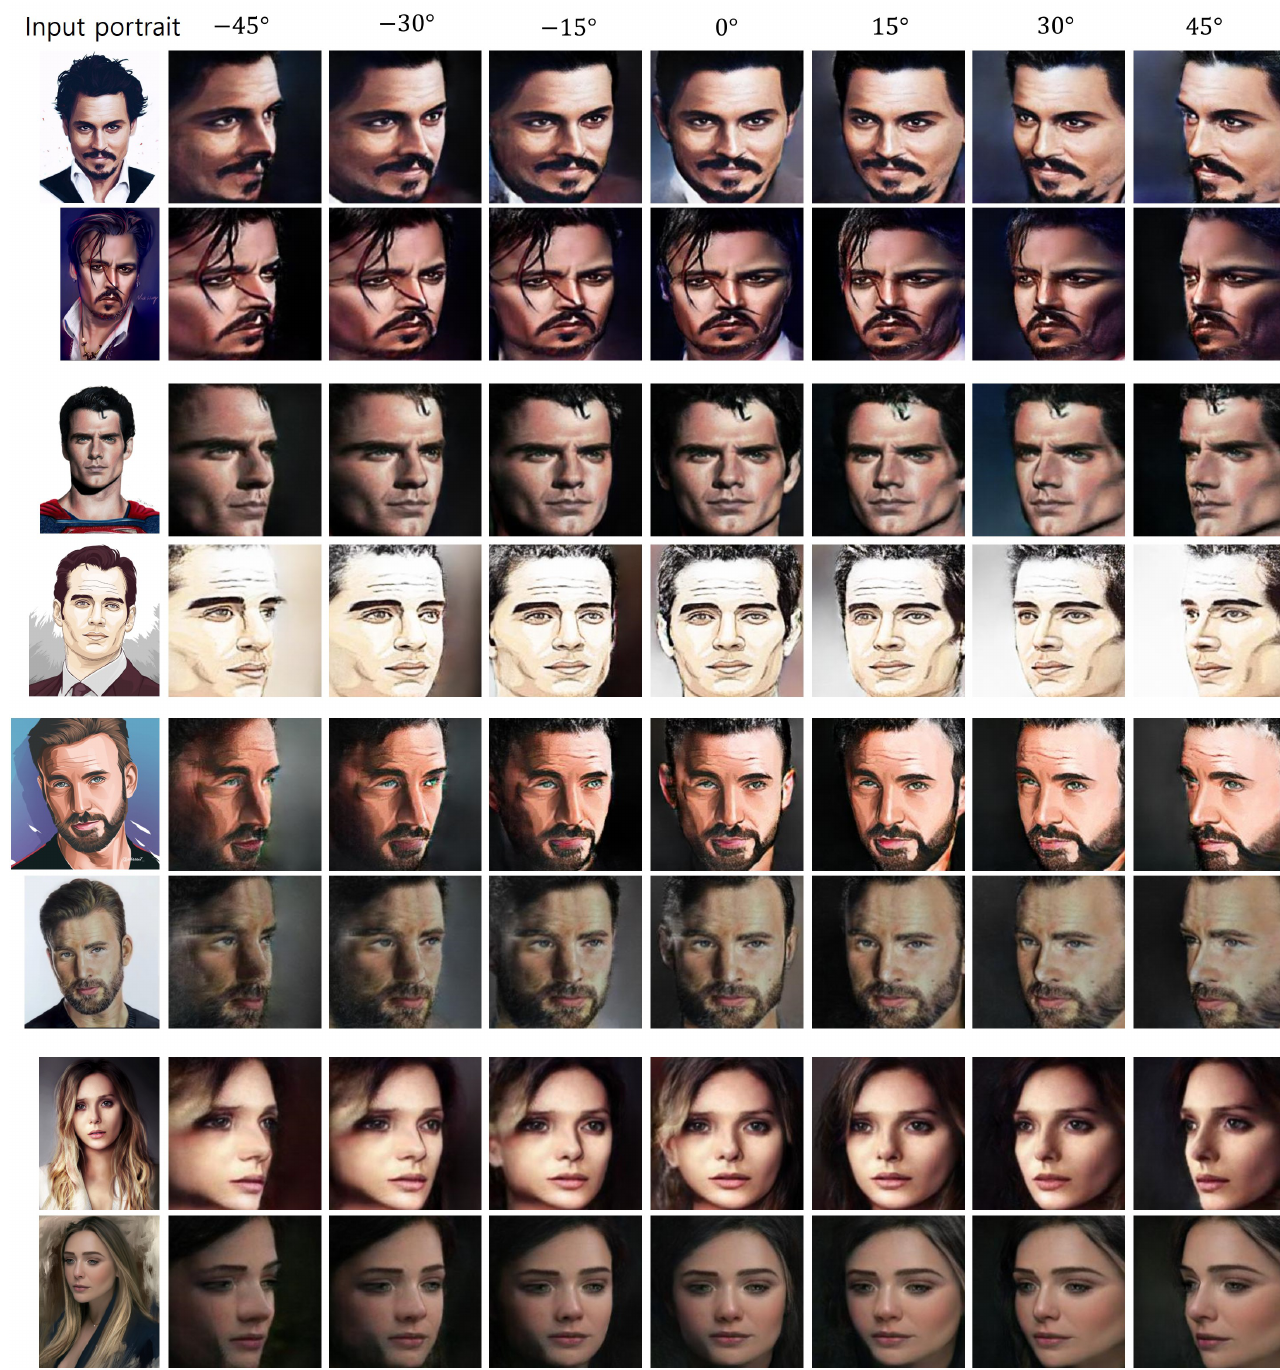
Figure 7. Portraits from CelebA, comparing same person with two